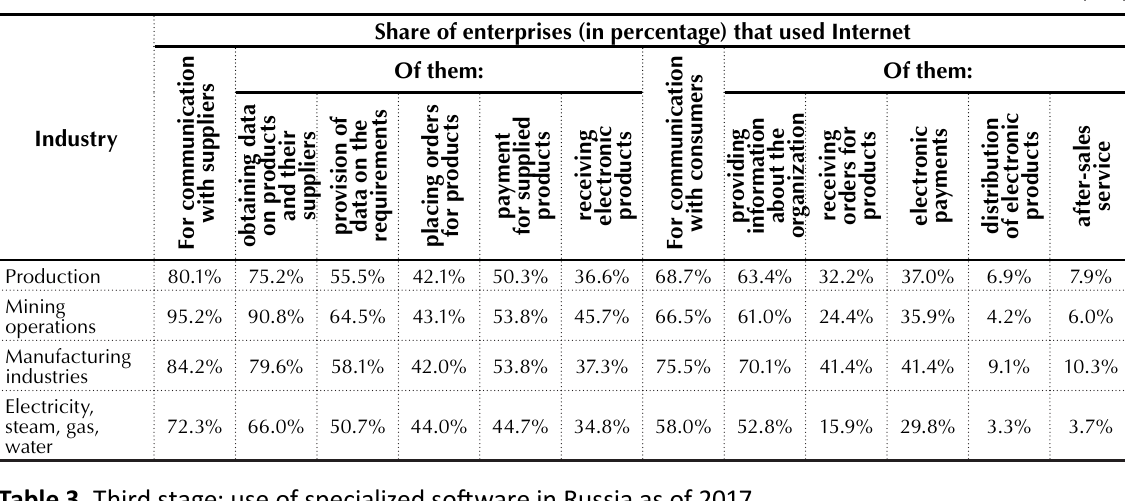
Table 3. Third stage: use of specialized software in Russia as of